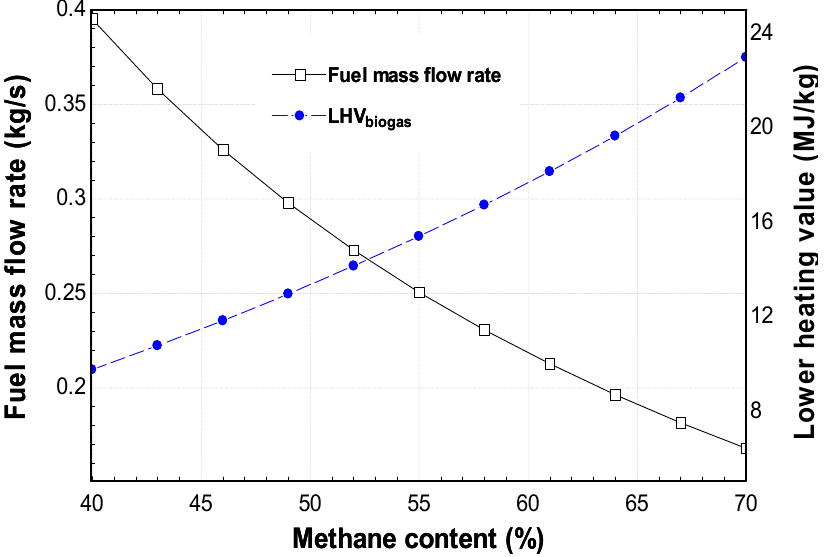
Figure 4. Effect of the biogas methane content on its lower heating value and mass flow rate.